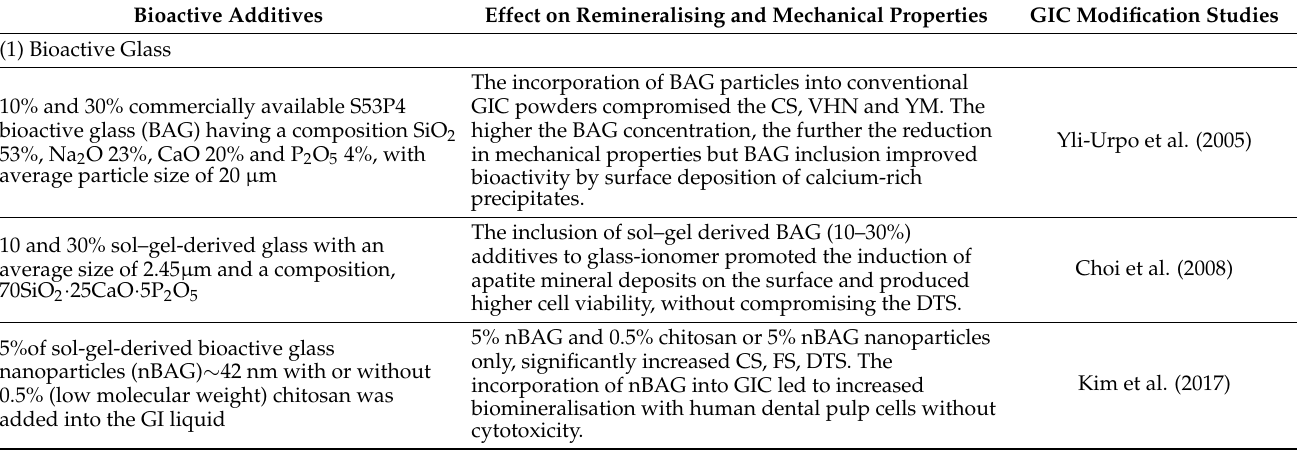
Table 1. Modification of GIC using various additives for the promotion of bioactivity